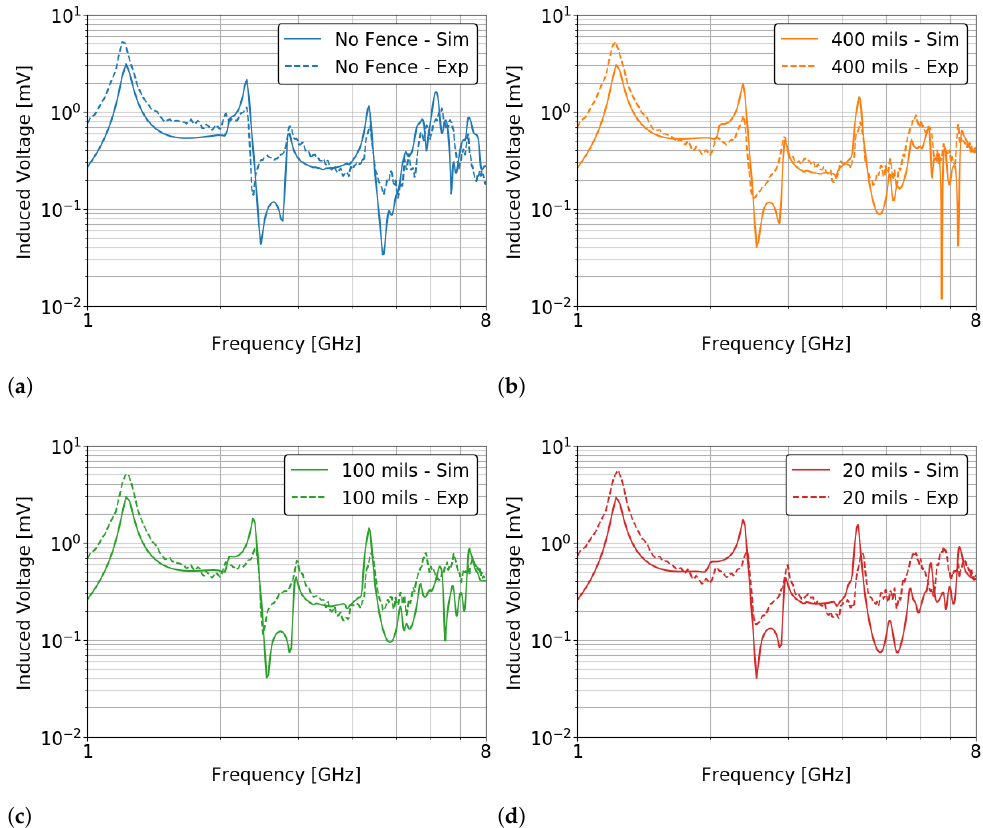
Figure 11. Comparison of simulated vs. experimentally measured induced voltage for each via fencing variation: ( a ) no via fence, ( b ) 400mil via spacing, ( c ) 100mil via spacing, and ( d ) 20mil via spacing. The experimental data validate the modeling results and give further proof that the dominant coupling mechanism is not at the PCB